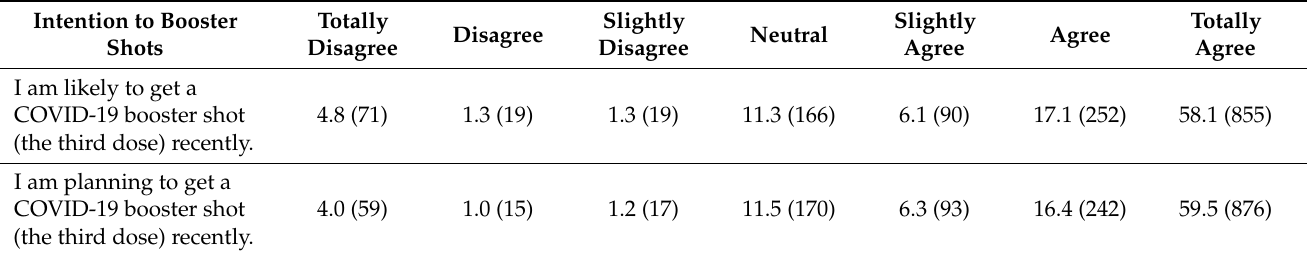
Table 3. Intention to take booster shots ( n = 1472).